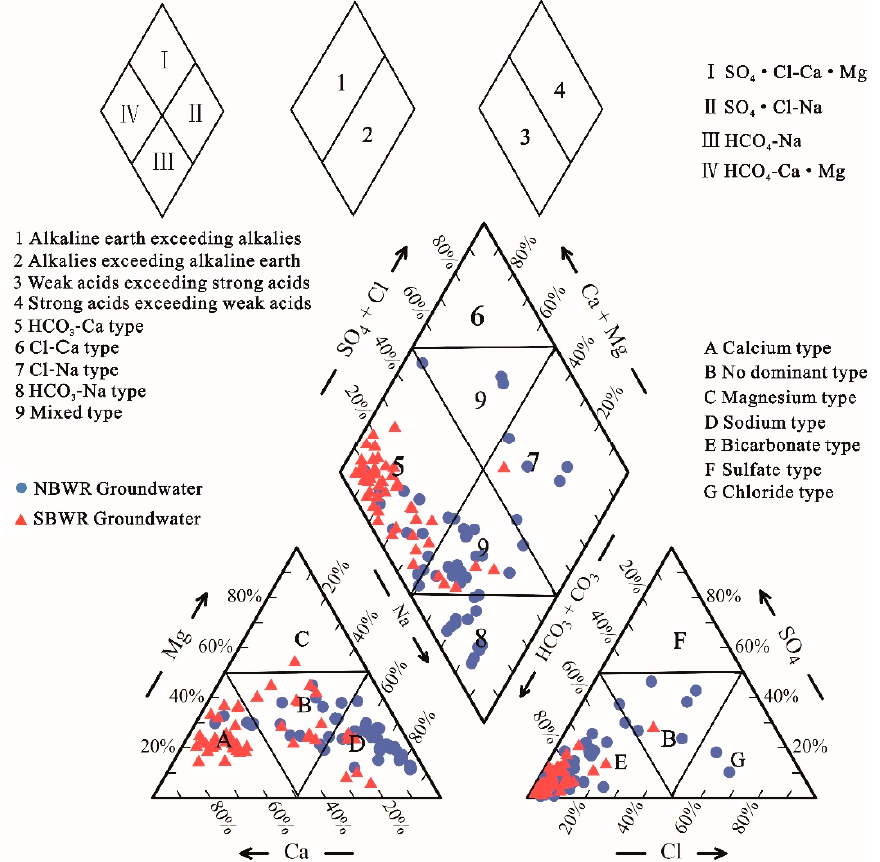
Figure 2. Piper diagram for groundwater samples.